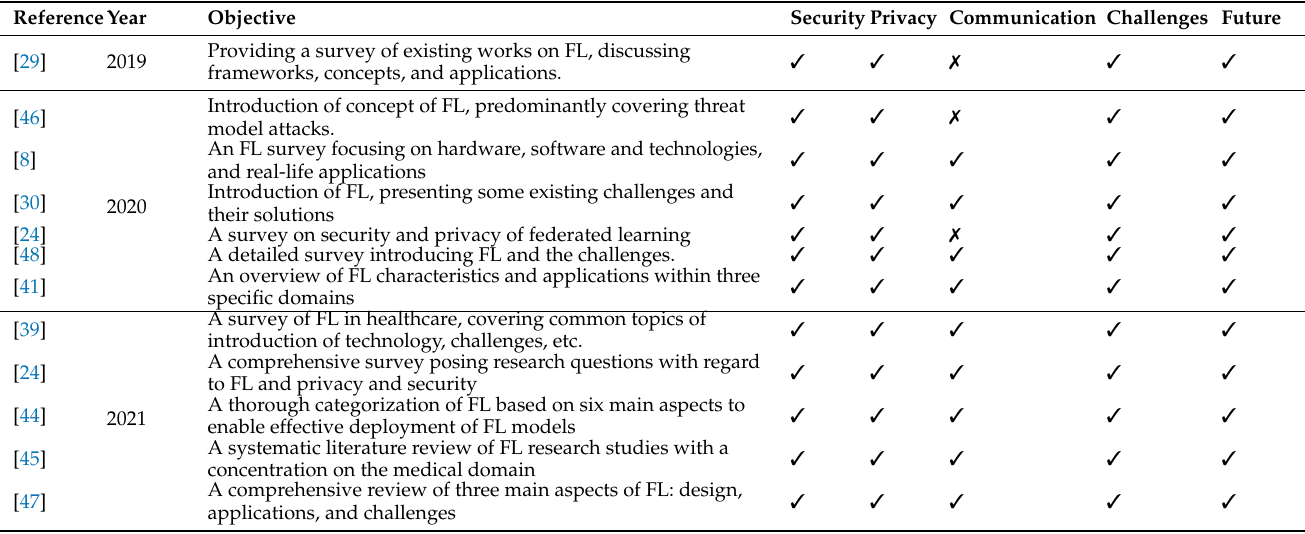
Table 1. Publication analysis of survey papers over the past couple of